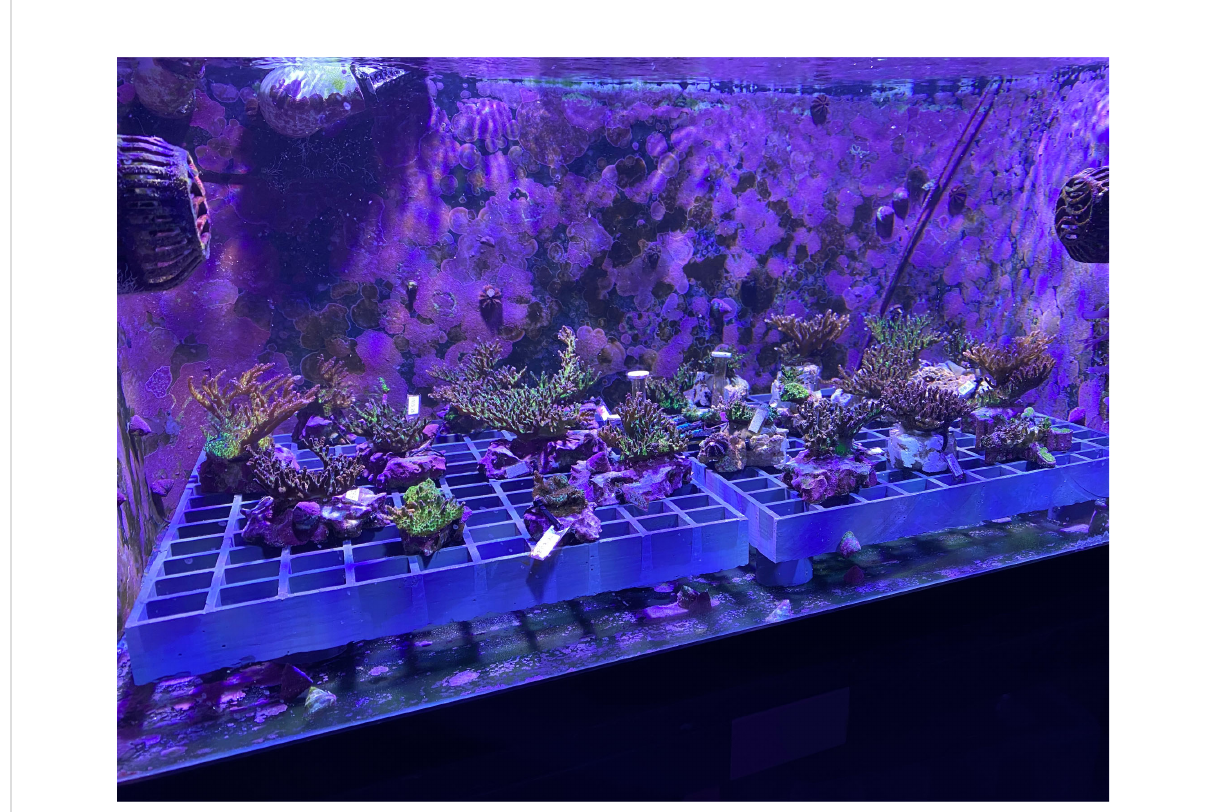
FIGURE 1 Photo of the F1s produced in 2019. This photo was taken shortly after tissue samples were collected from these individuals, in June 2021 when the F1s were two years